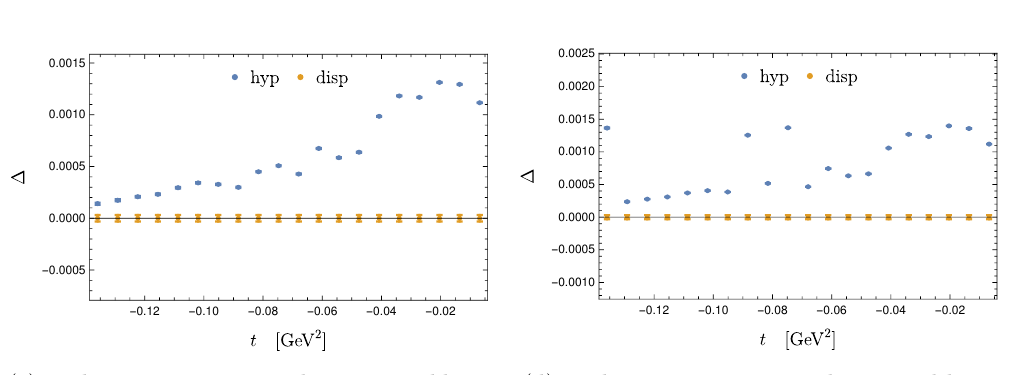
(d) Hadronic correction to the crossed box. Figure 8. The relative di(cid:11)erence (cid:1) between the box-Born interferences (with leptonic or hadronic vacuum polarization) calculated by the hyperspherical and the dispersive method for t p s = 0 : 405 GeV and 0 : 142 Gev 2 0 GeV 2 . The result given by the dispersive method is used (cid:0) (cid:20) (cid:20) as normalization factor. The error bars show the uncertainty due to the numerical